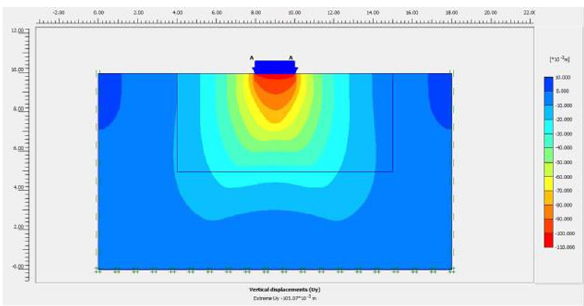
Fig. 21 Soil settlement under the foundation in soil without con- tamination